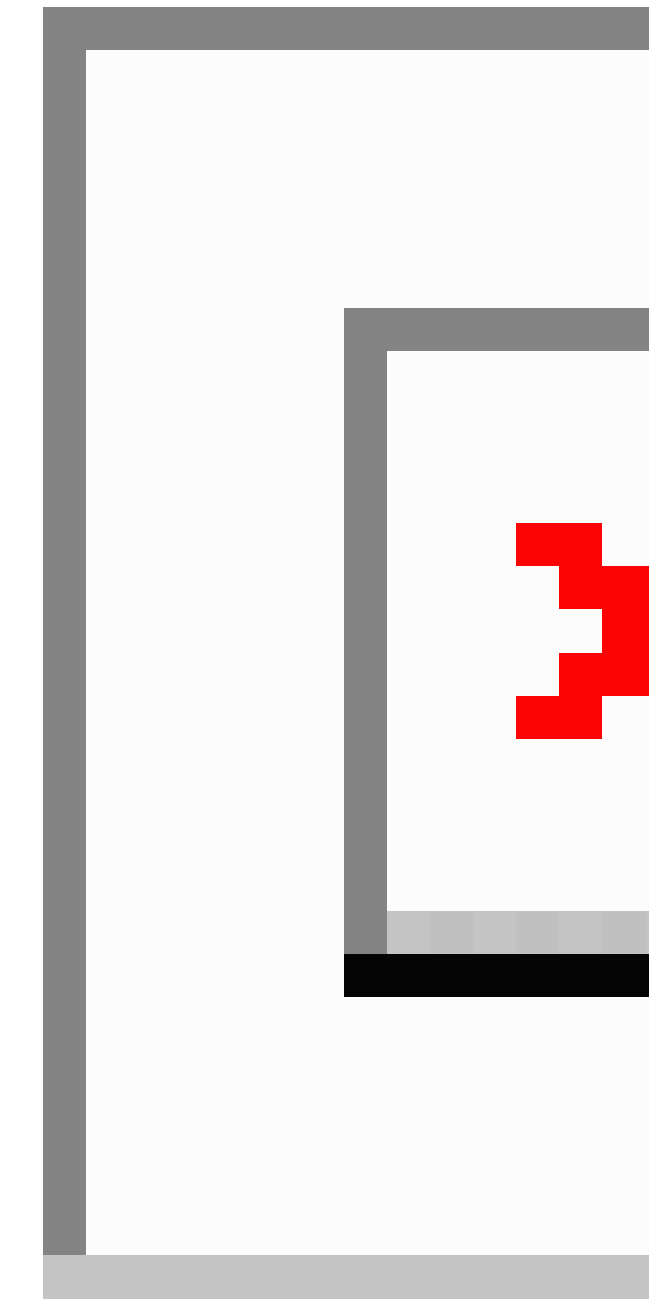
Figure 2. Grounded theory model resulting from